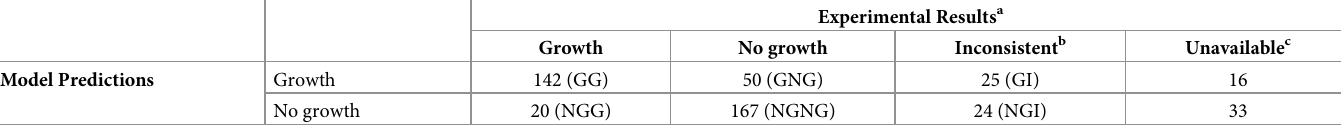
Table 2. Comparison of in silico predictions of single knockout mutants vs. pooled experimental results for anaerobic growth in minimal